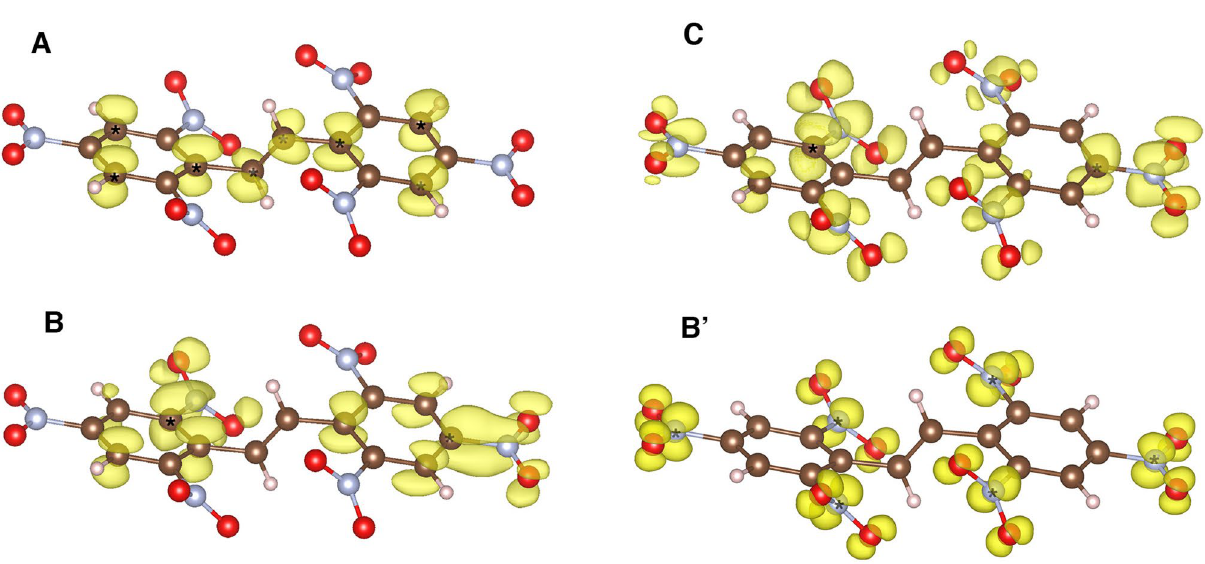
Figure 4. Excited state charge densities contributing to peaks in the carbon and nitrogen 1 s spectra as indicated in Fig. 3. Atoms color code and labeling as in Fig.